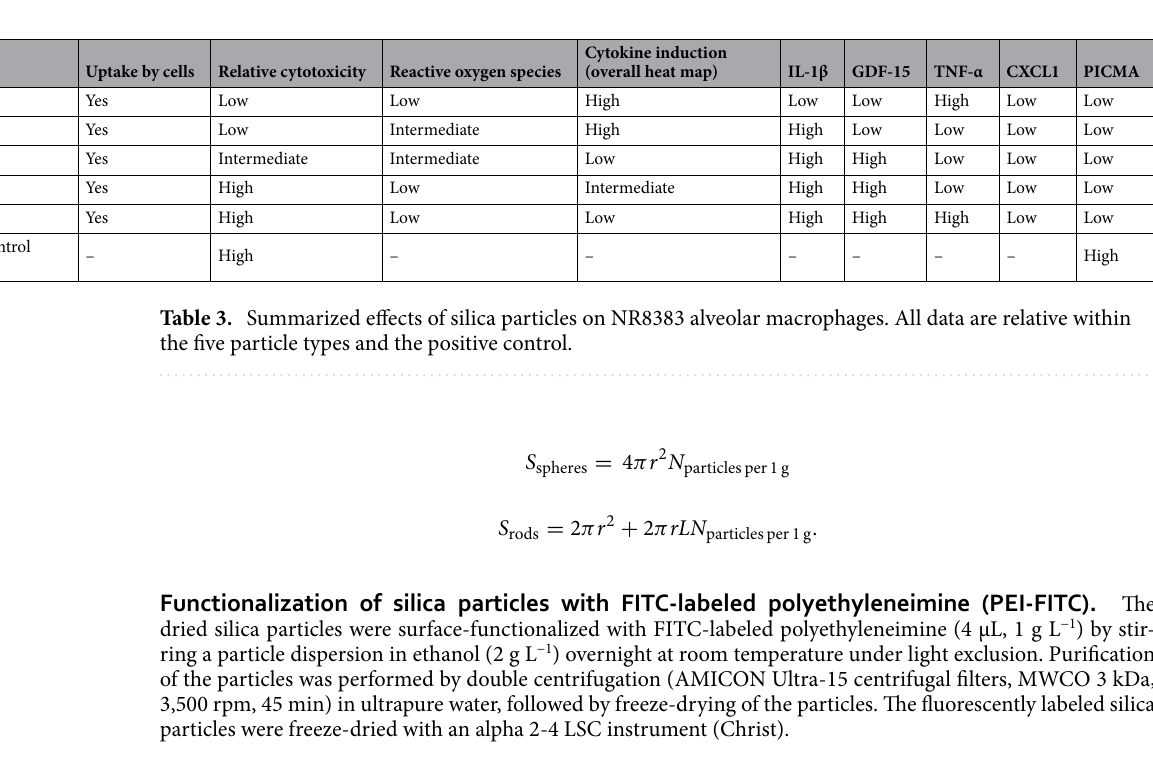
Cytokine induction (overall heat